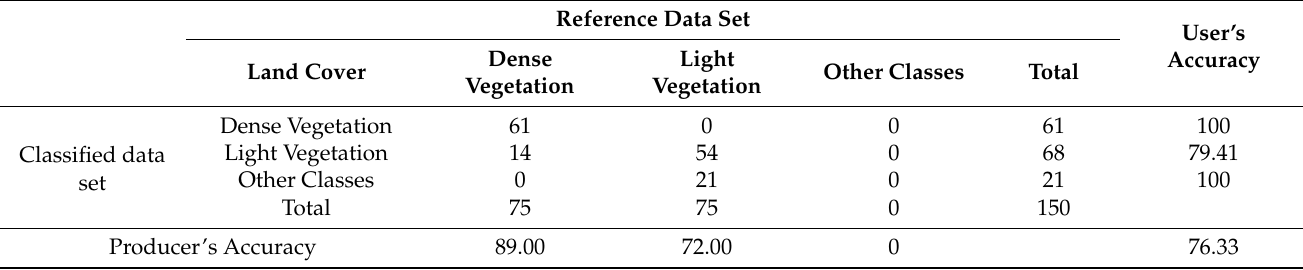
Table 7. Confusion matrix for the referenced and classified dataset.